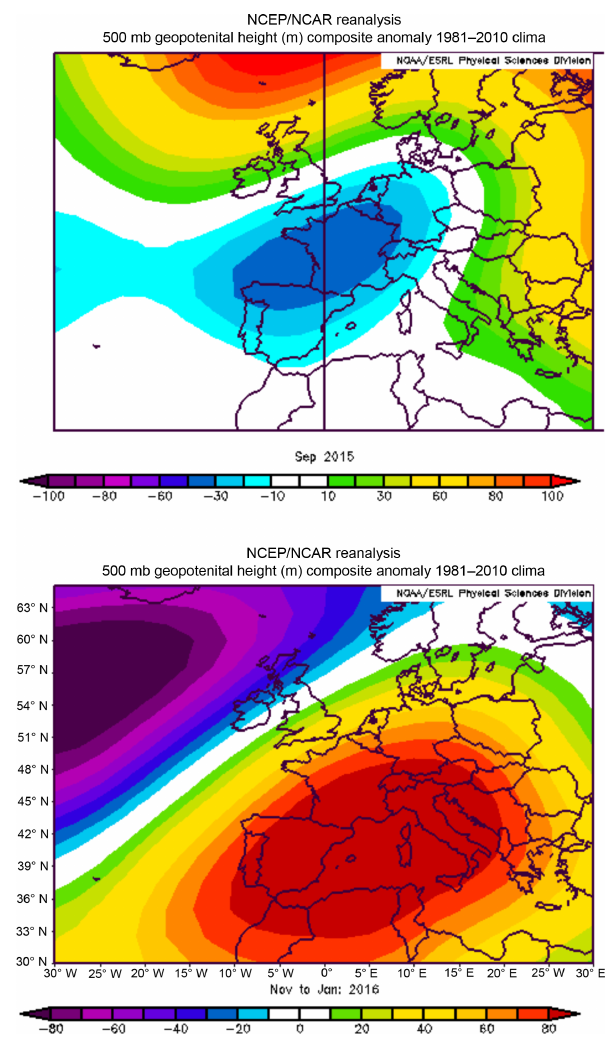
Figure 13. Geopotential height anomalies at 500hPa for September 2015 and for November 2015–January 2016, referring to the refer- ence period 1981–2010 (source NCEP/NOAA